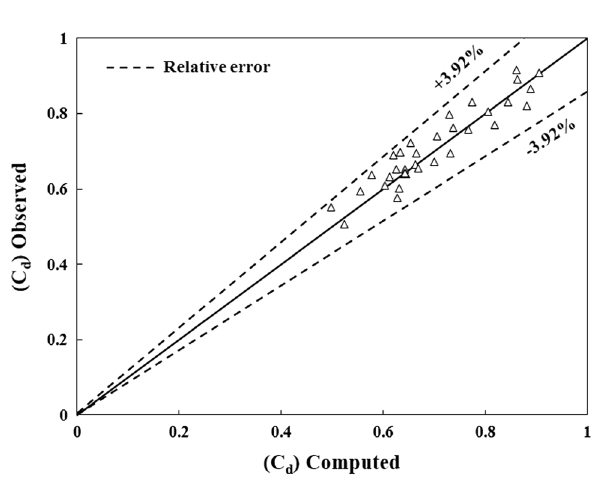
Fig. 10 Variations in numerical data with estimates from (main equa- tion, Eq. 3) for the TSESW